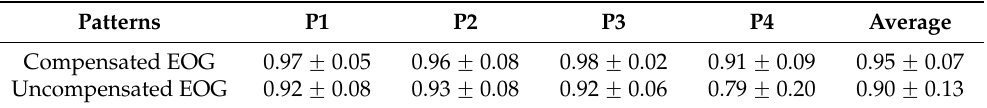
Table 1. Pearson’s correlation coefficients between the recorded vertical EOG components and ideal EOG components.